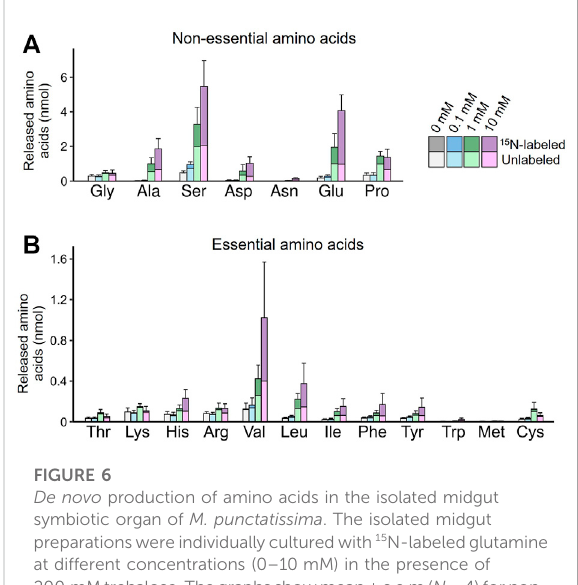
FIGURE 6 De novo production of amino acids in the isolated midgut symbiotic organ of M. punctatissima . The isolated midgut preparationswereindividuallyculturedwith 15 N-labeledglutamine at different concentrations (0 – 10 mM) in the presence of 200 mMtrehalose.Thegraphsshowmean±s.e.m( N =4)fornon- essential amino acids (A) and essential amino acids (B) , with the labeled and unlabeled fractions coded by different